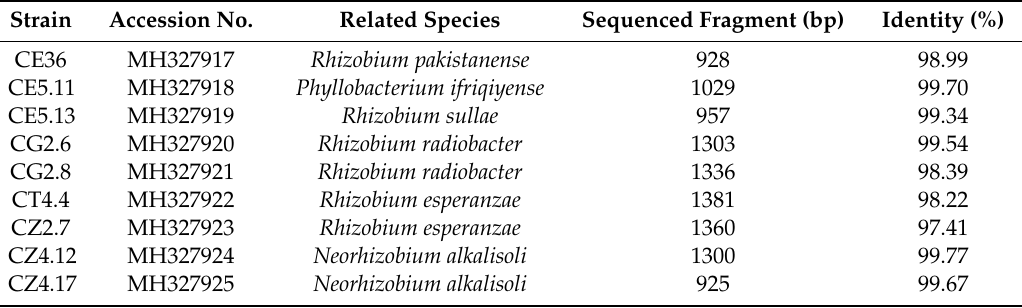
Table 2. Closest species to the representative strains isolated from Calicotome villosa based on the 16S rRNA partial sequence using EzTaxon server